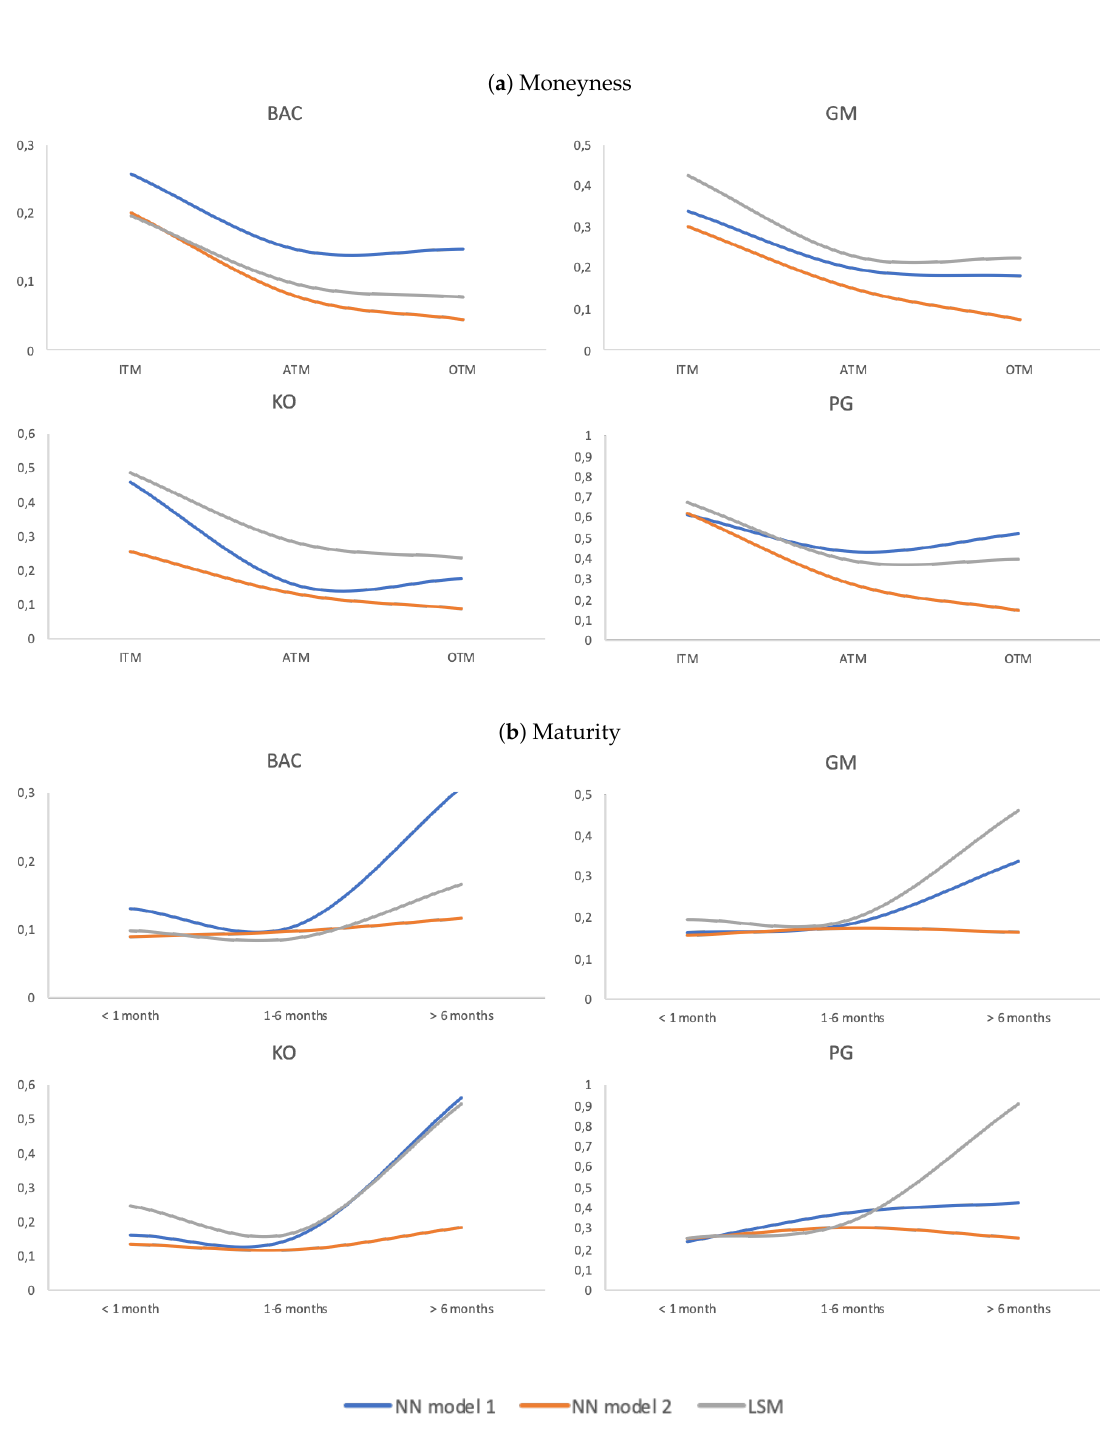
Figure 10. RMSE per company: moneyness and